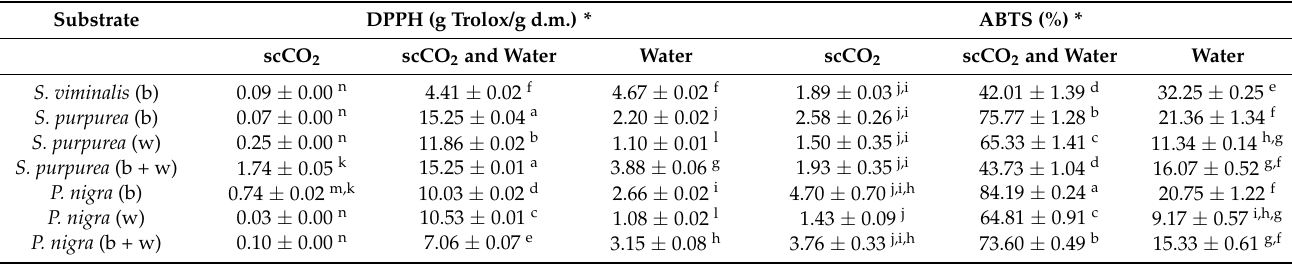
* Mean values of three different determinations followed by standard deviation are presented; b—bark, w—wood, b + w—a mixture of bark and wood. The different letters ( a–n ) in the same group indicate significant differences between the samples ( p <